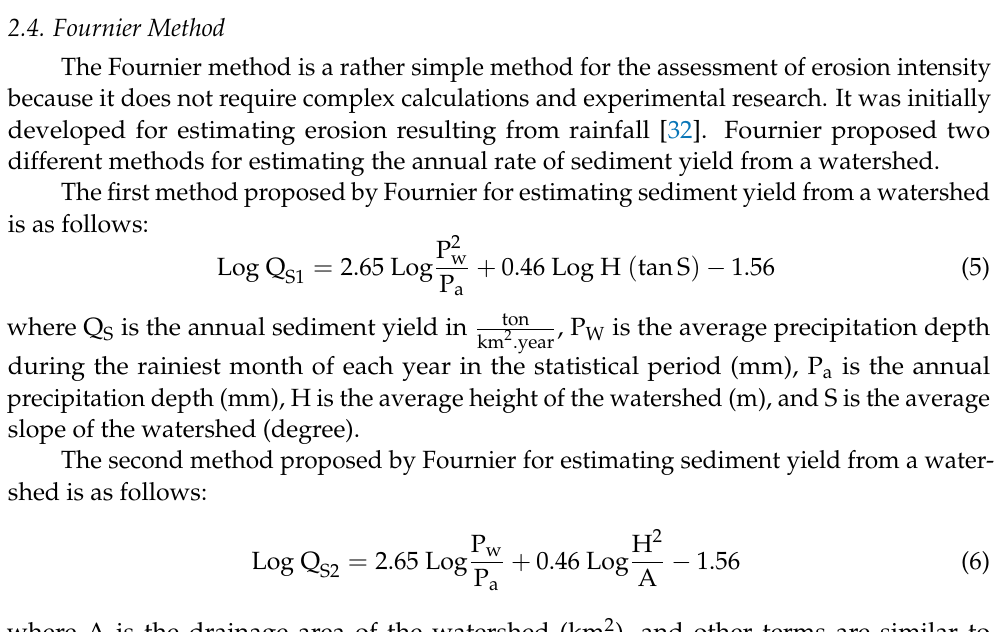
Table 4. Classification of erosion intensity in EPM method. Ranges Erosion Intensity Erosion Classification Z > 1 Very high V 0.71 < Z < 1